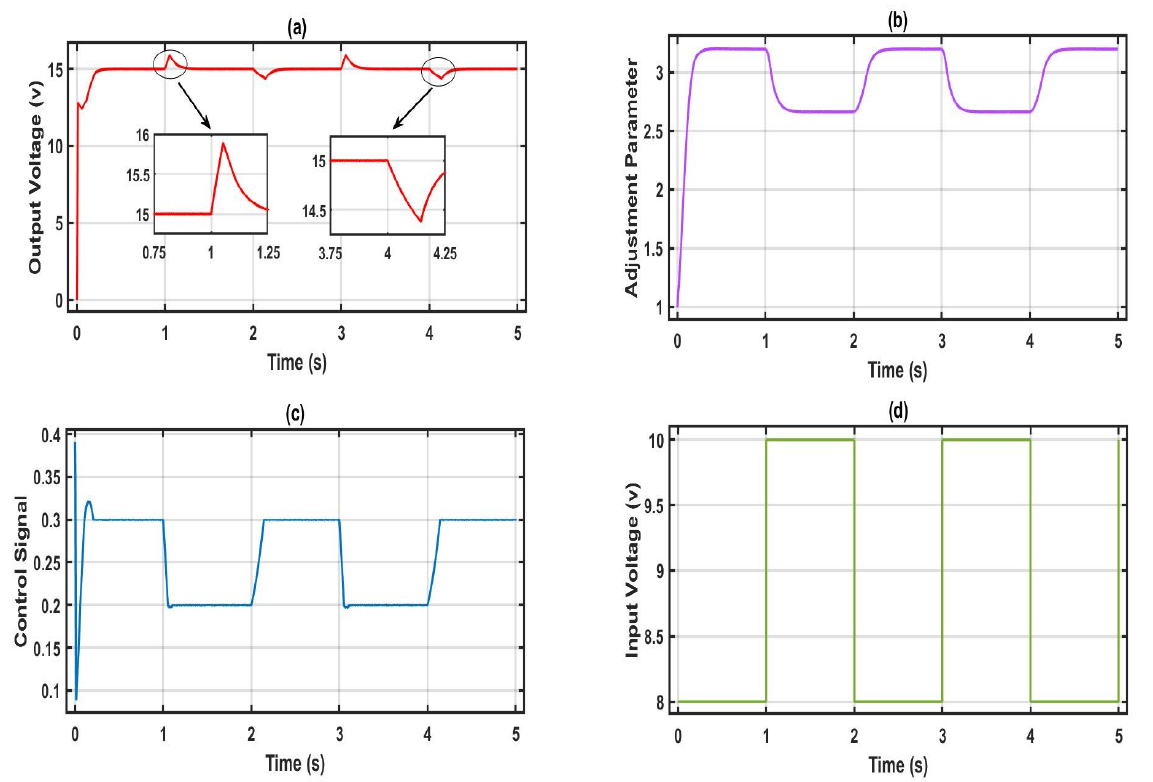
Figure 11. Simulation results: ( a ) The DC–DC converter transient output voltage and the responses to the input voltage changes from 8 V to 10 V (and vice-versa), ( b ) PID controller adjustment coefficient, ( c ) control signal waveform for the input voltage changes and ( d ) input voltage changes from 8 V to 10 V (and vice-versa).